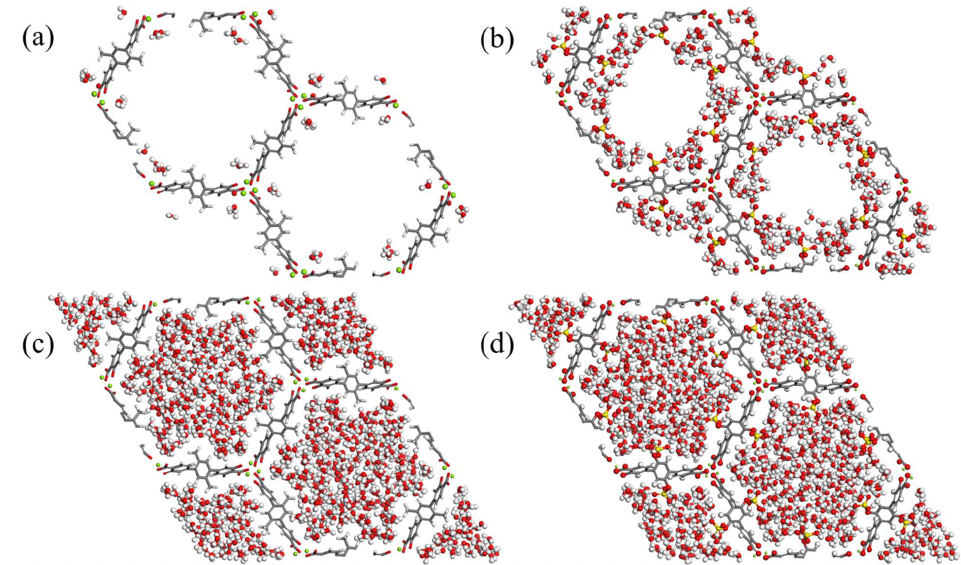
Figure 8. Snapshots taken from the GCMC simulations for the parent MOF-74-III material at 10% RH ( a ) and 60% RH ( c ) and for the –OSO 3 H functionalized at 10% RH ( b ) and 60% RH ( d